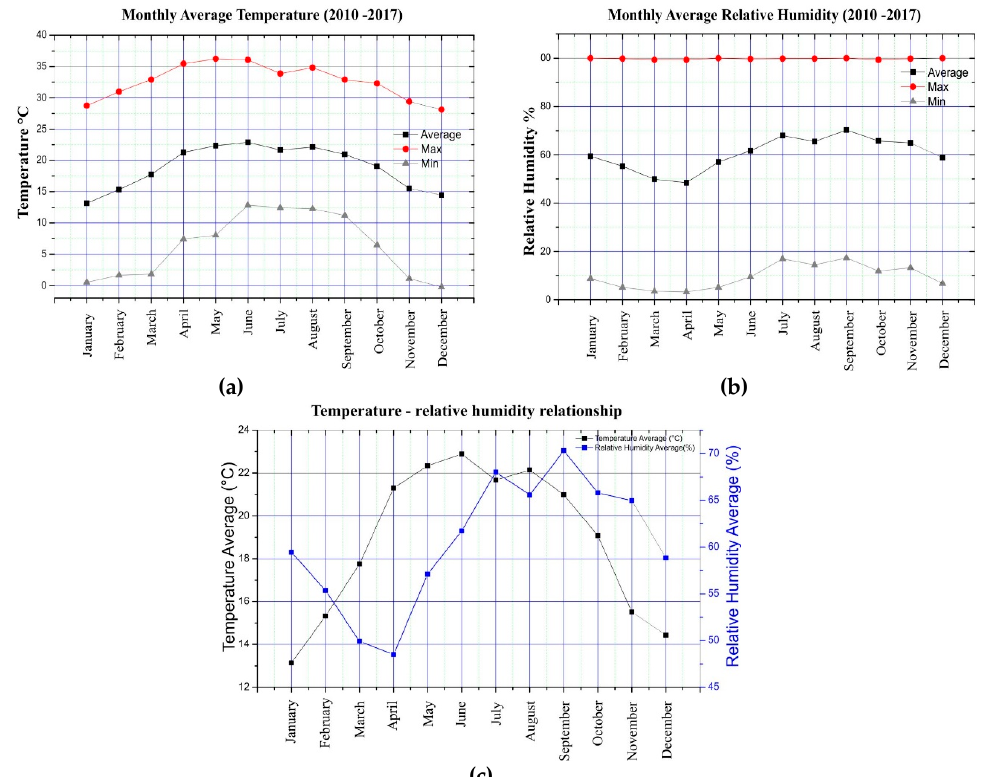
Figure 2. Statistical data of ( a ) temperature, ( b ) relative humidity (RH) and ( c ) humidity and temperature ratio in Matehuala, SLP, Mexico (2010 – 2017).